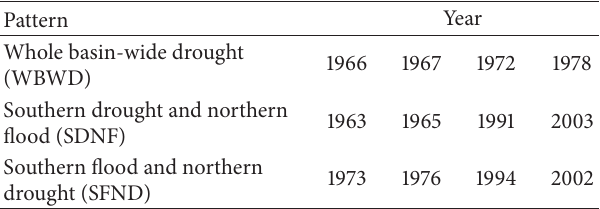
Table 2: The typical drought years of the three summer drought patterns of the